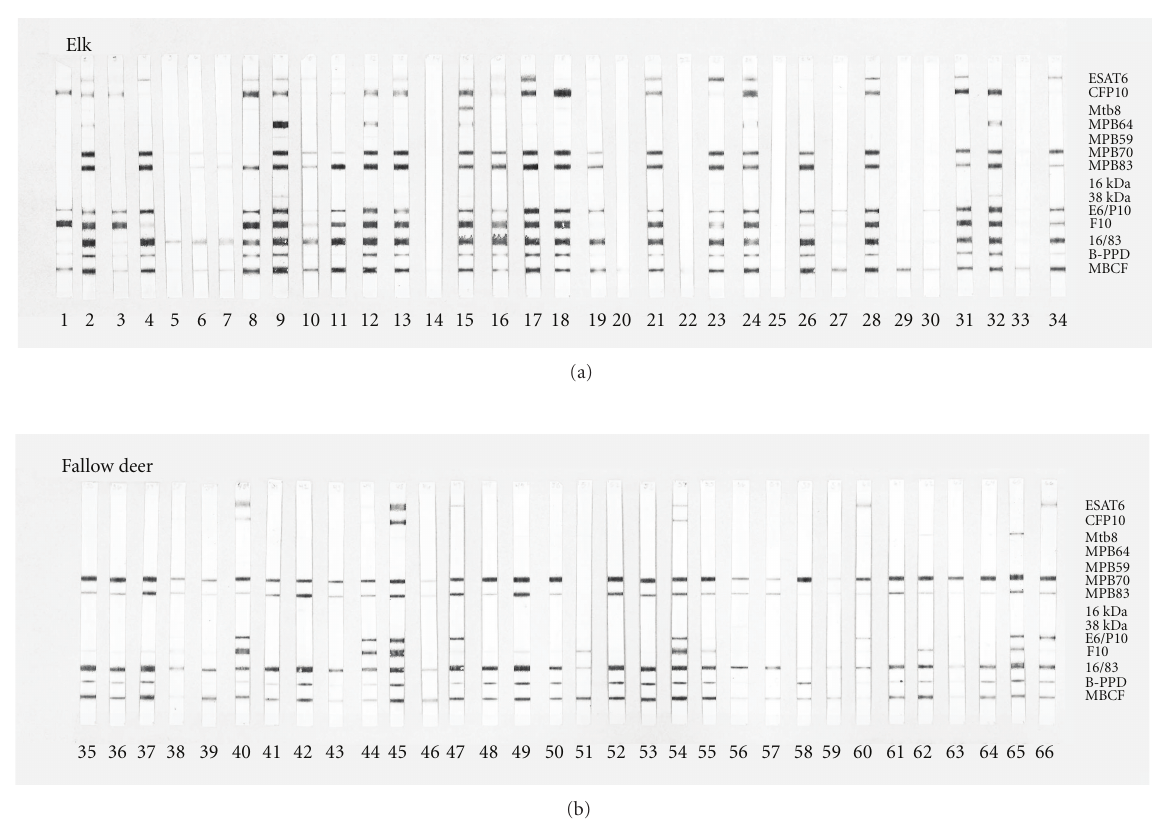
Figure 3: Antibody responses to recombinant and native antigens detected in elk (a) and fallow deer (b) using a multiantigen print immunoassay. Numbers in lower margins indicate unique animal identification designations. Antigens printed on nitrocellulose are indicated in the right margin. E6/P10 refers to a fusion protein of ESAT-6 and CFP10. 16/83 refers to a fusion protein of the 16kDa protein and MPB83. F10 is a fusion protein consisting of CFP10, secE2, and PhoS1/pstS. B-PPD refers to M. bovis -derived purified protein derivative. MBCF refers to M. bovis -derived culture filtrate